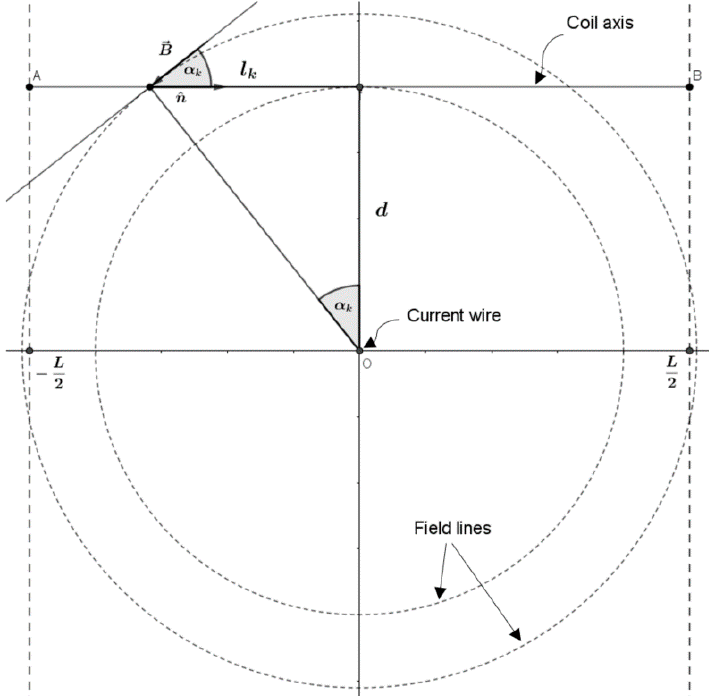
Figure A1 . Geometrical representation of the infinitely long current wire with a coil as seen from the top.